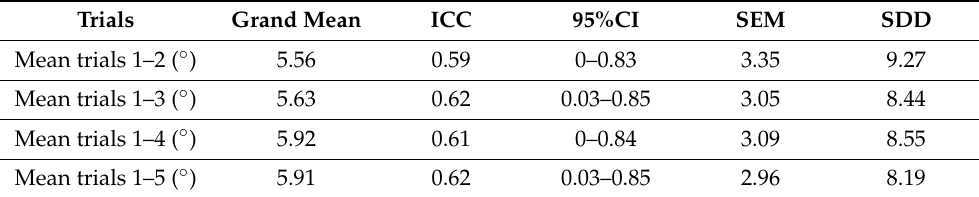
Table 3. Inter-rater reliability of the double inclinometer method for the assessment of thoracolumbar joint position sense. Trials